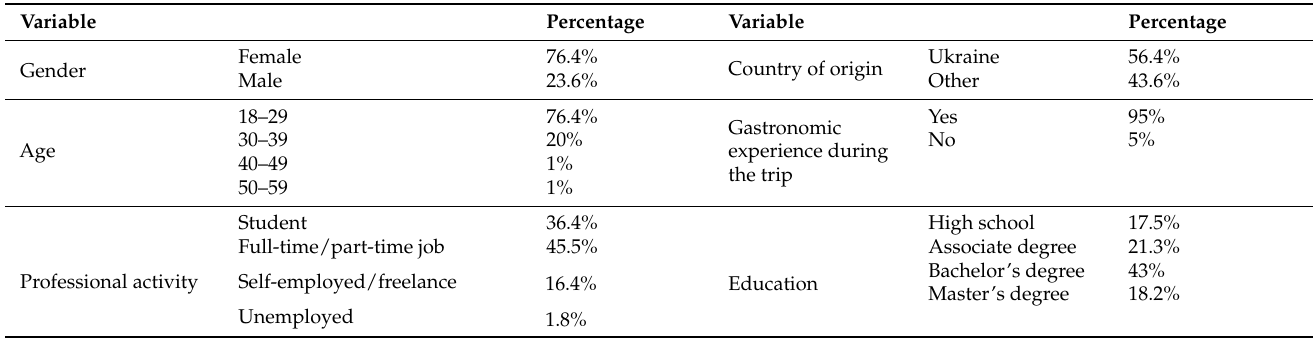
Table 2. Respondents